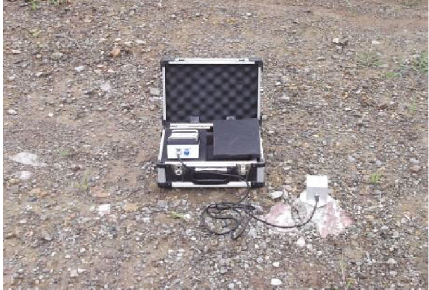
Figure 6: TC-4850 blasting vibration